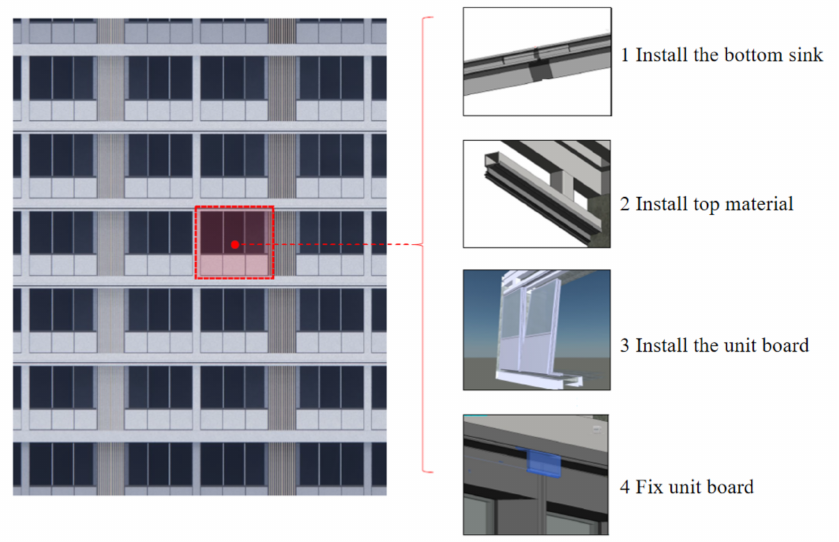
Figure 5. Curtain wall installation